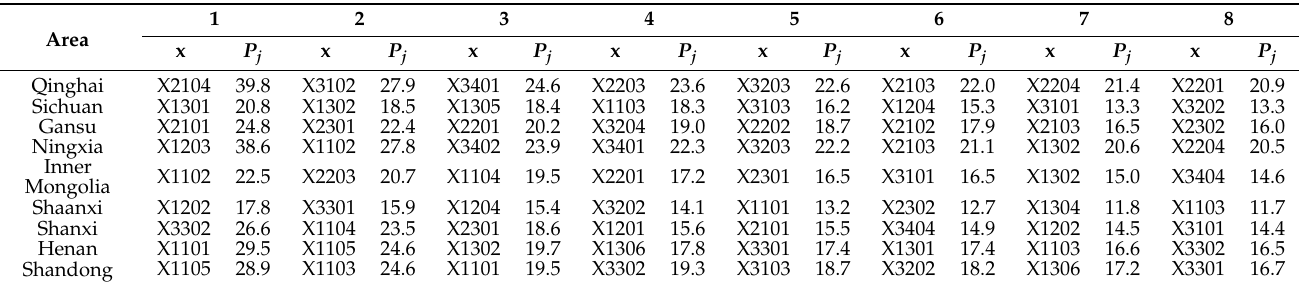
Table 8. Index barriers of provinces in the Yellow River